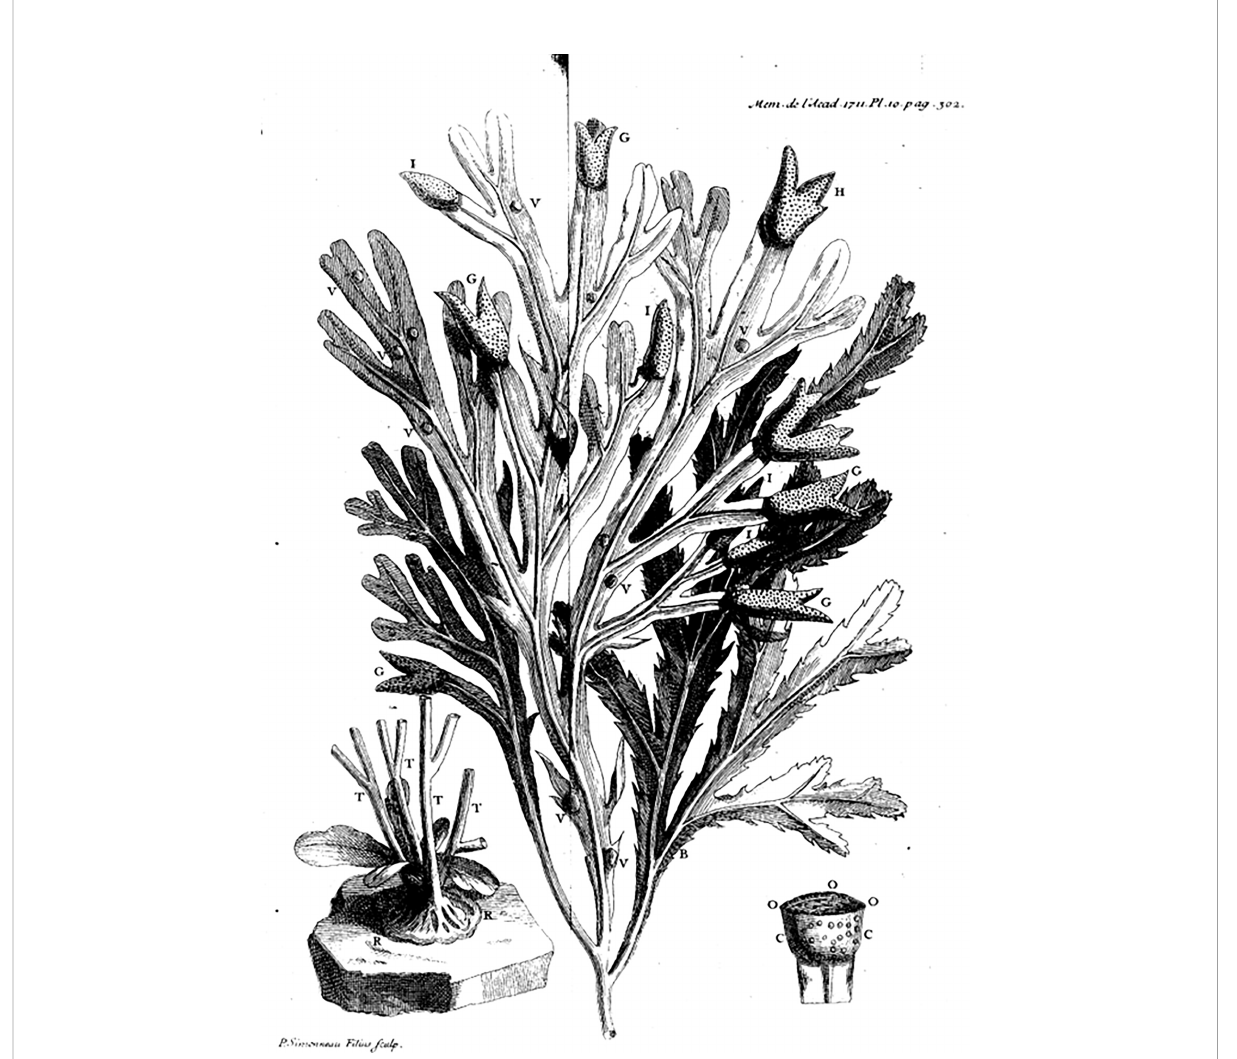
FIGURE 1 Illustration of Fucus serratus from Re ́ aumur (1711). Note that one thallus appears to have receptacles and vesicles characteristic of F. vesiculosus , perhaps mistakenly interpreted as stemming from the same holdfast, when in fact, it may be two independent attachments, one on the other (see insert). Permission to reuse this image was con fi rmed by Service des Archives et du Patrimoine historique under the free use of public archive